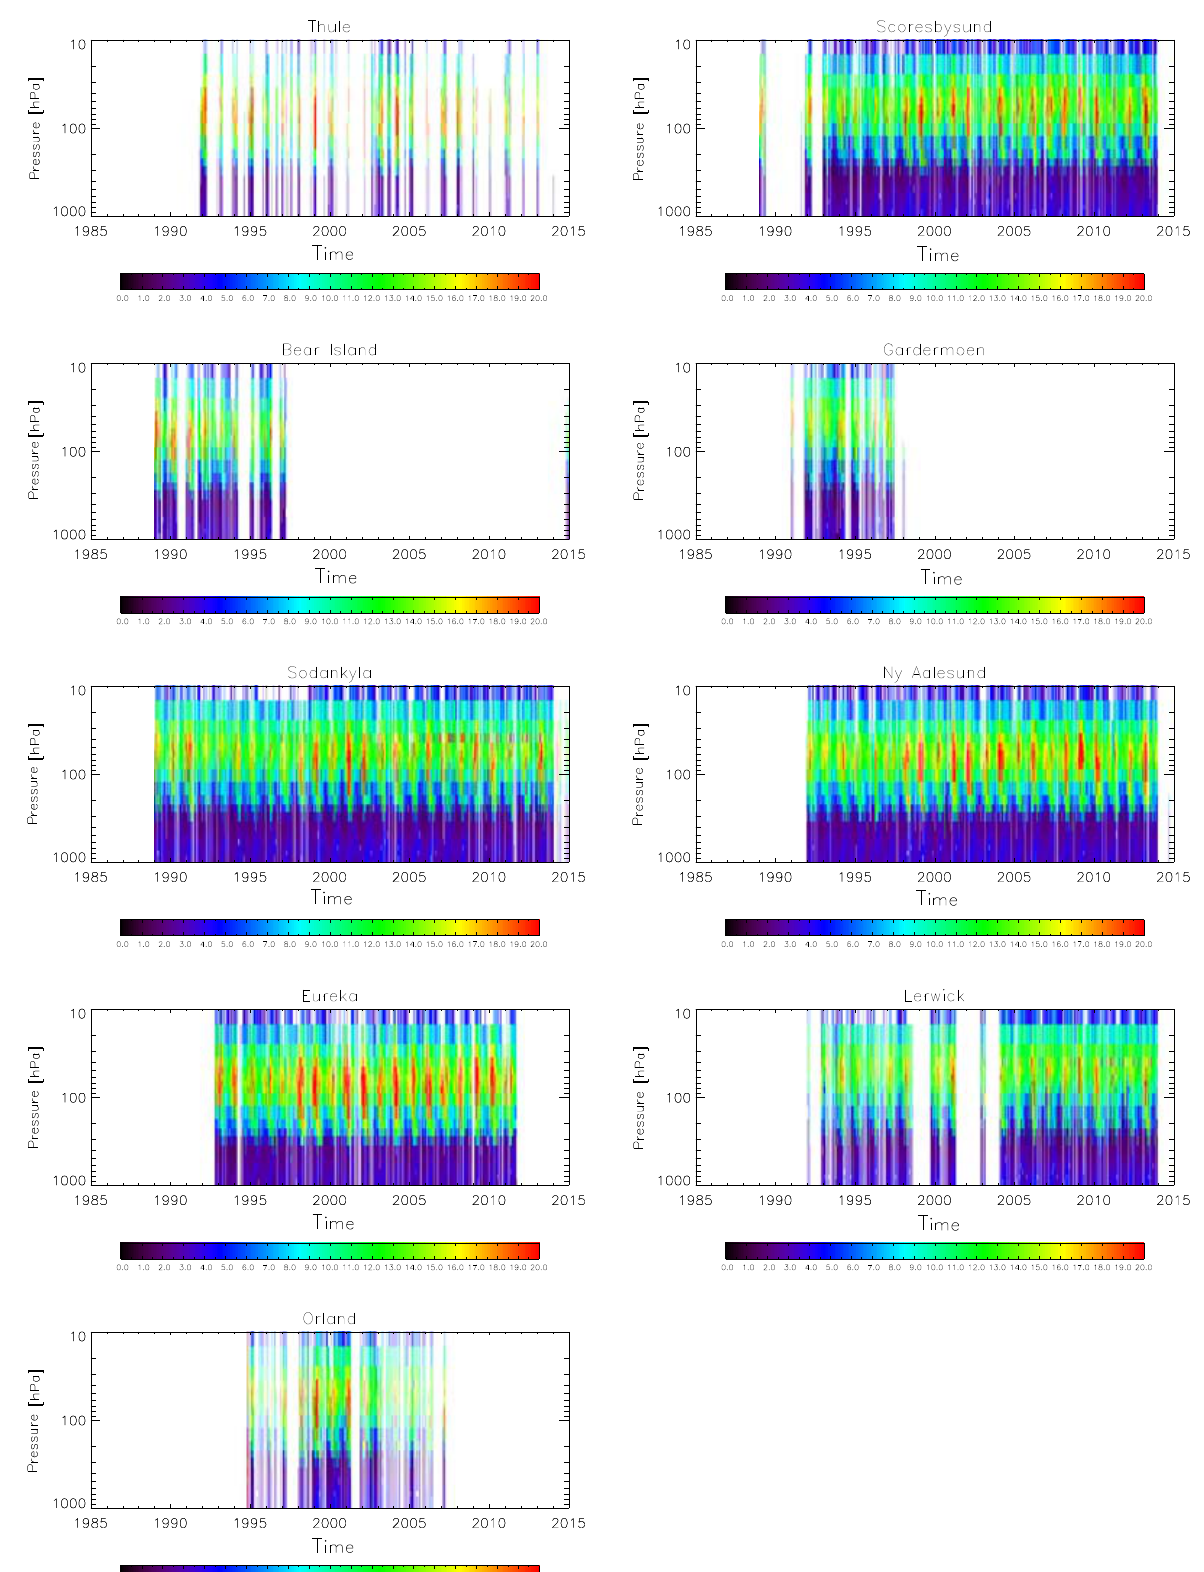
Figure 3. Ozone partial pressure (mPa) as a function of time and pressure for the nine